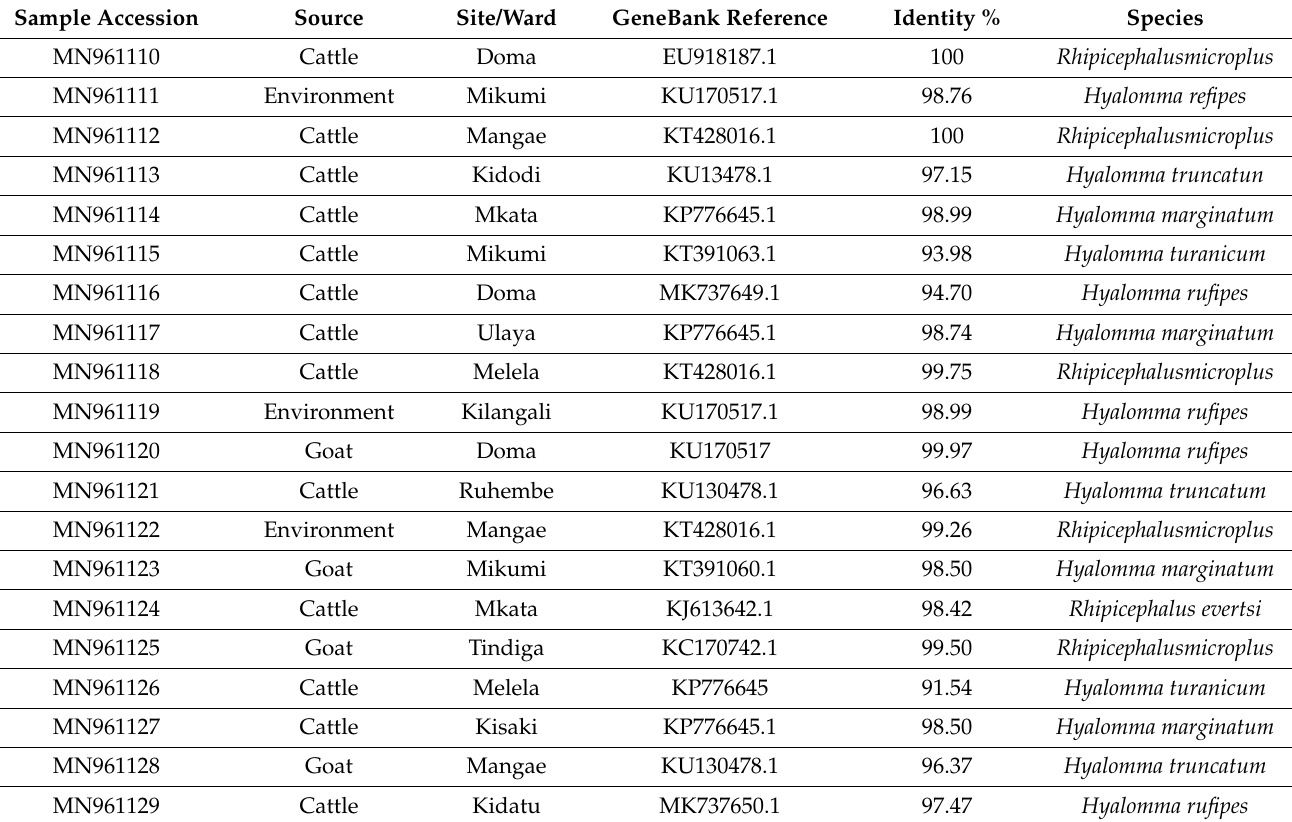
Table 5. Identity of tick species and percentage similarity value with the reference